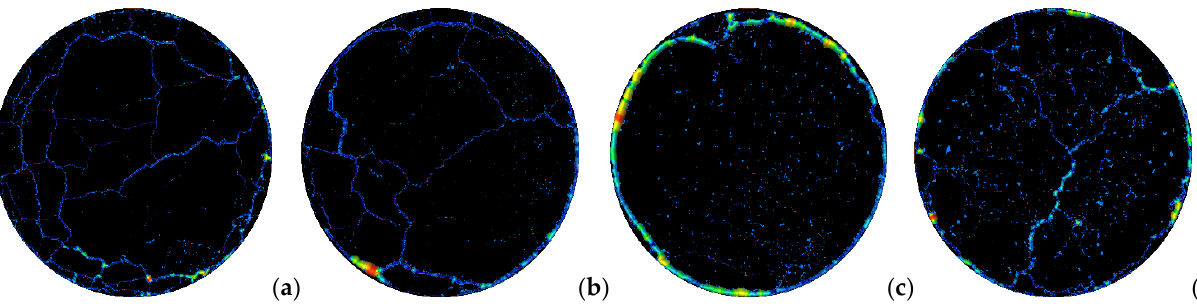
Figure 15. Cracks in soil sample after 12 WD cycles: ( a ) 0.25 mm; ( b ) 0.50 mm; ( c ) 2.00 mm; ( d ) 5.00 mm.